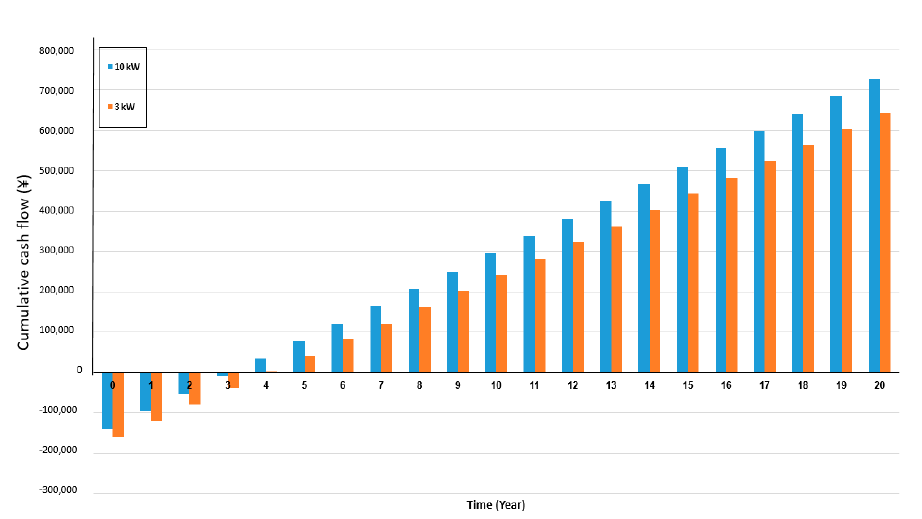
Figure 7. Calculation of investment payback period.